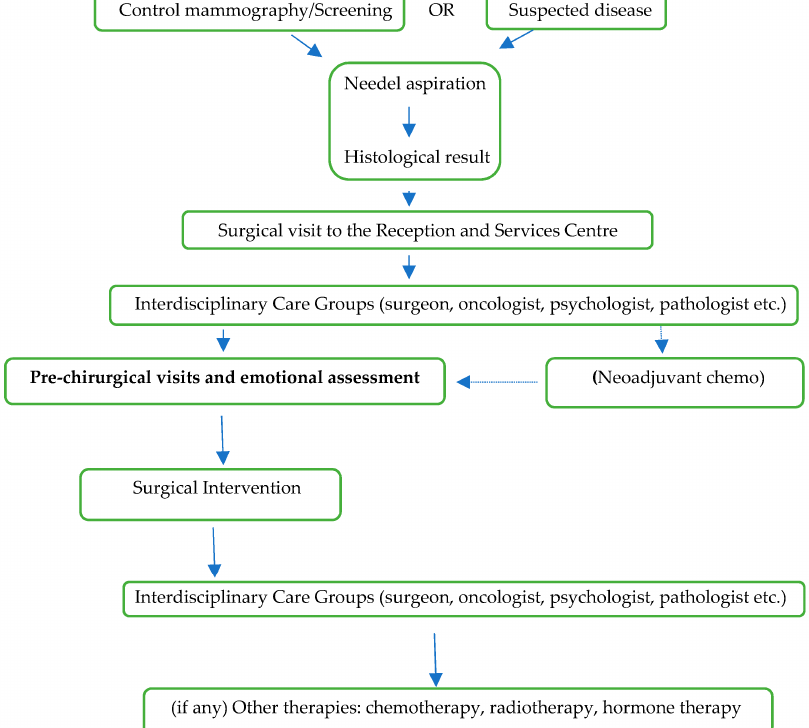
Figure 1. Plan of the cancer diagnosis.